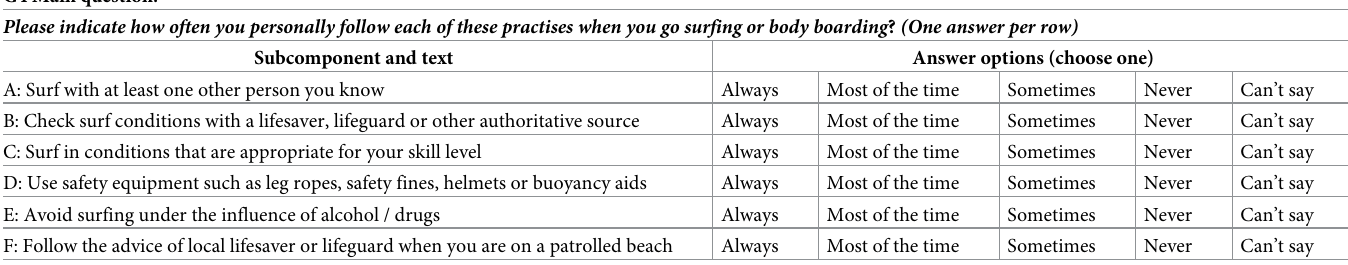
Table 2. Example question (G4) from 2020